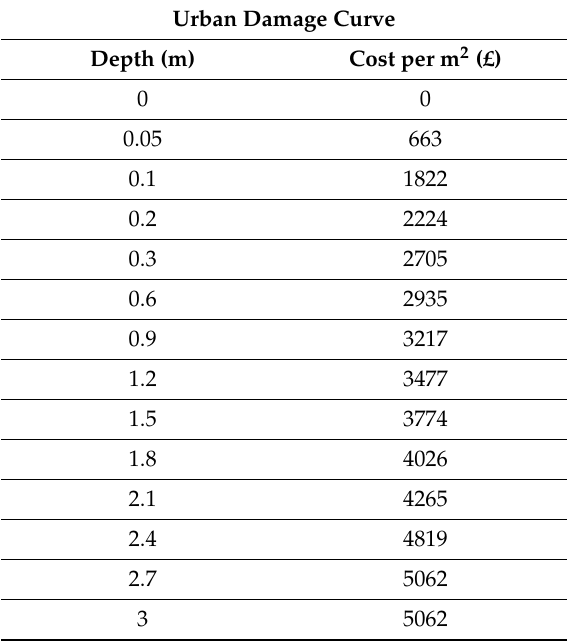
Table 3. Saltwater Depth Damage (£) for Urban Flood Inundation Cells